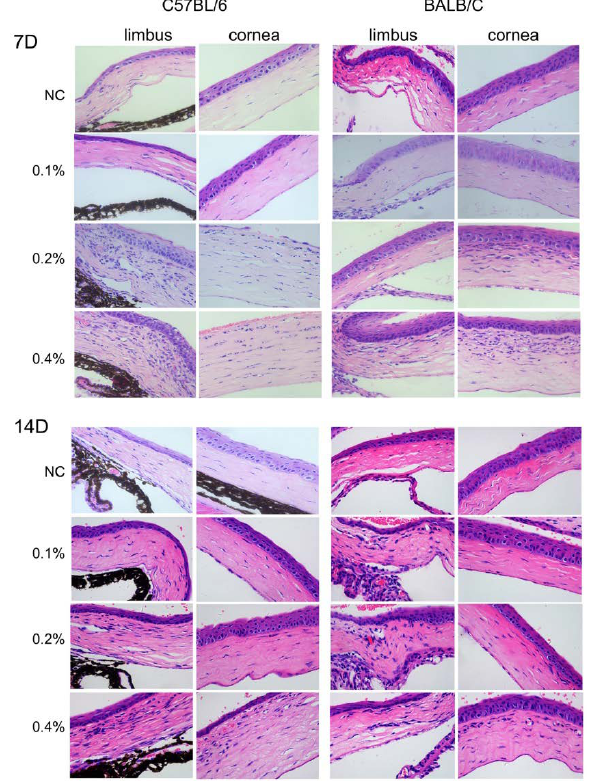
Figure 4. Histological evaluation of corneal alterations induced by the administration of BAC eye drops for 7 and 14 days. Hematoxylin/eosin staining of corneal sections shows disruption of the epithelial layer of the cornea, neovascularization, and infiltration of inflammatory cells in the peripheral and central cornea. Strong responses were observed in tissue sections from the C57BL/6 mice (vs. the BALB/c mice), in sections from mice that received a high dose of BAC (in the following order: 0.4% > 0.2% > 0.1% > NC), and in sections obtained on Day 7 (vs. Day 14). All pictures are at the same magnification (400 ×